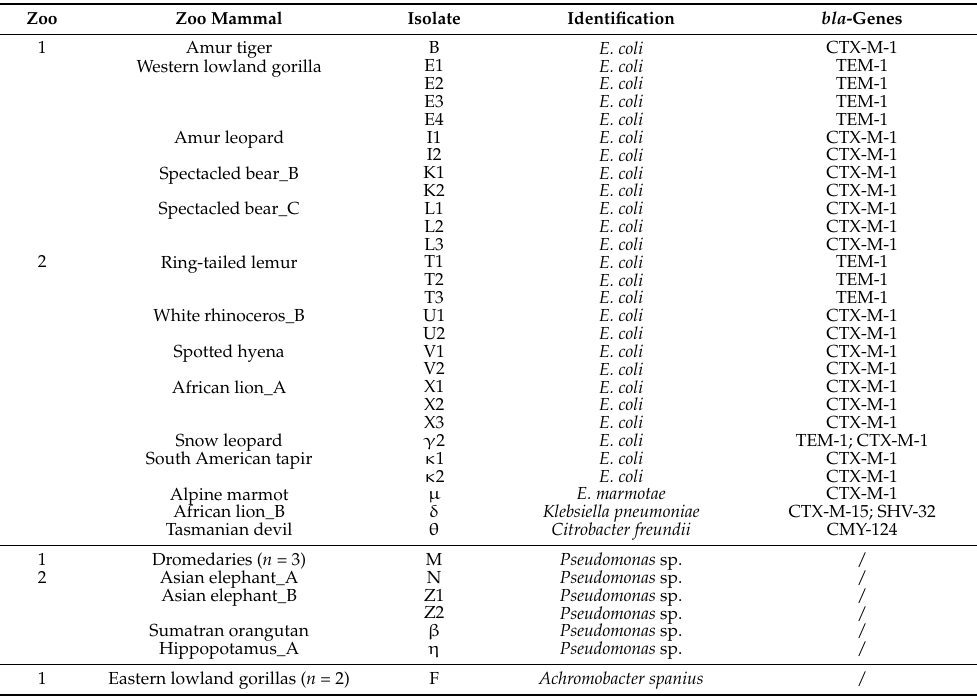
Table 1. Identification of 35 ceftiofur-resistant isolates obtained from fecal samples of zoo mammals and overview of detected bla -genes in these